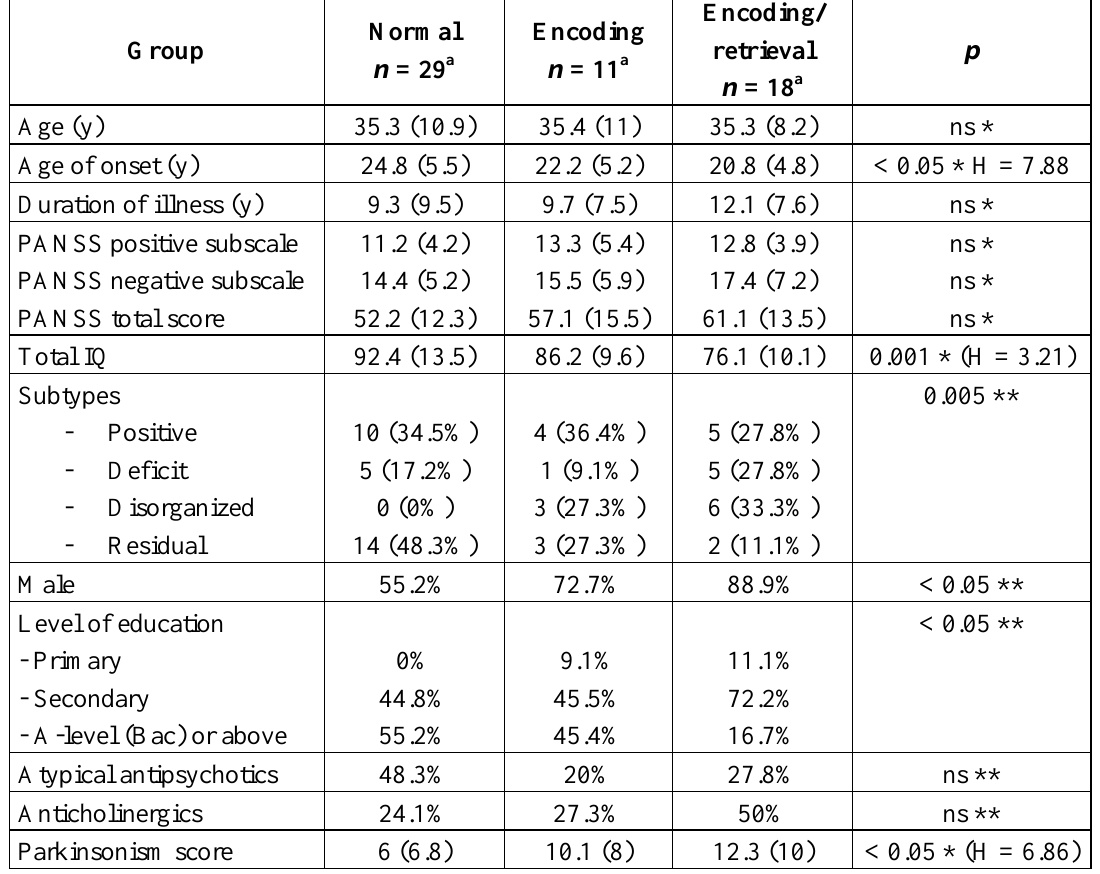
Table 3. Clinical and demographic characteristics of schizophrenia patients grouped according to mnesic